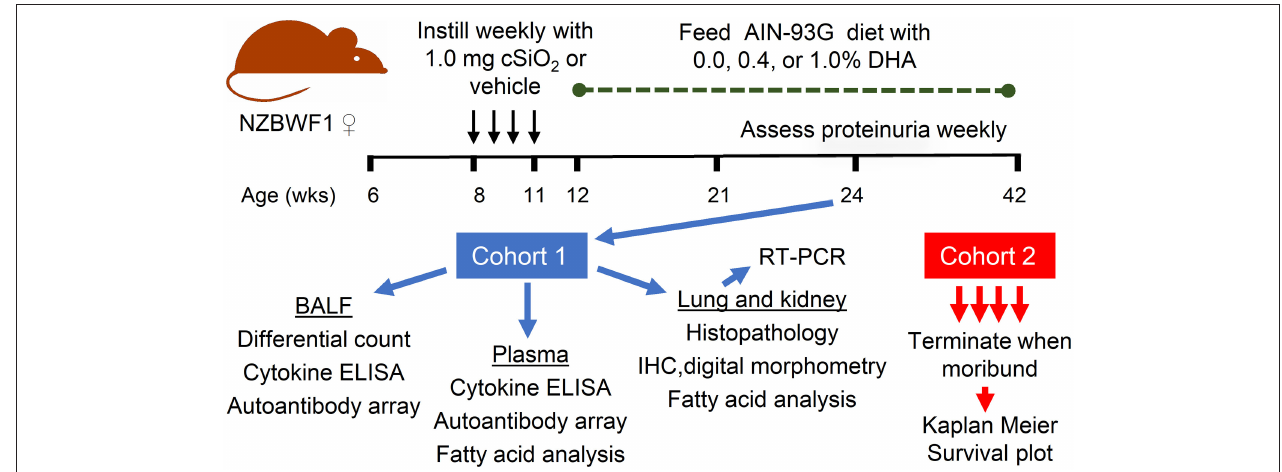
FIGURE 1 | Experimental design. Female NZBWF1 were obtained at 6 week of age and initiated on AIN-93G diet containing 0.0% DHA. At age 8 week, mice were intranasally instilled with 1.0mg cSiO 2 or Veh once per week for 4 weeks. One week following the final cSiO 2 instillation, animals were either maintained on the control diet or fed diets containing 0.4 or 1% DHA (w/w). Eight animals per exposure/diet group (cohort 1) were sacrificed at 24 weeks, at which time BALF was collected for differential cell counts, cytokine ELISAs, and assessment of autoantibodies; plasma collected for cytokine ELISAs, assessment of autoantibodies, and fatty acid analysis; lungs and kidneys collected for histopathology, IHC and digital morphometry, RT-PCR, and fatty acid analysis. The remaining 8 animals per exposure/diet group (cohort 2) were monitored until moribund, at which point they were humanely euthanized. During this time, proteinuria was assessed weekly as a measure of disease progression.